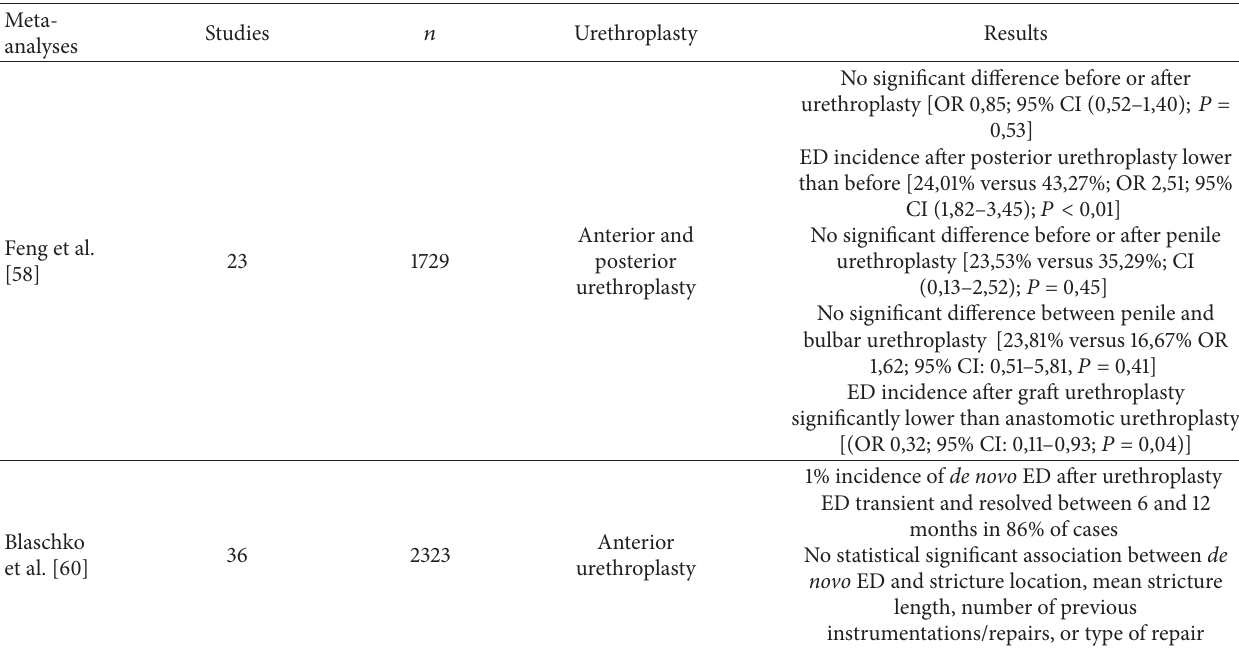
Table 5: Meta-analyses, erectile